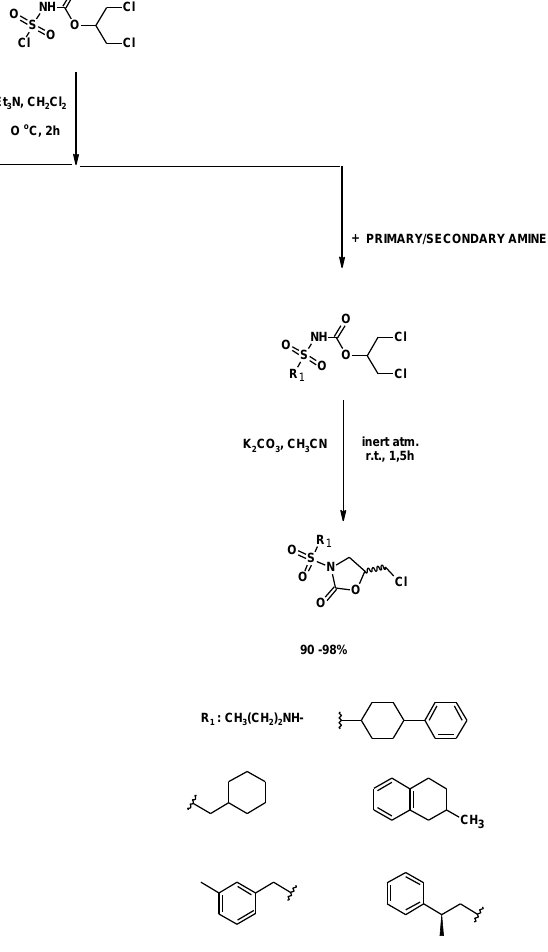
Figure 24. Synthesis of sulphamoyloxazolidinones from 1,3-DCH.